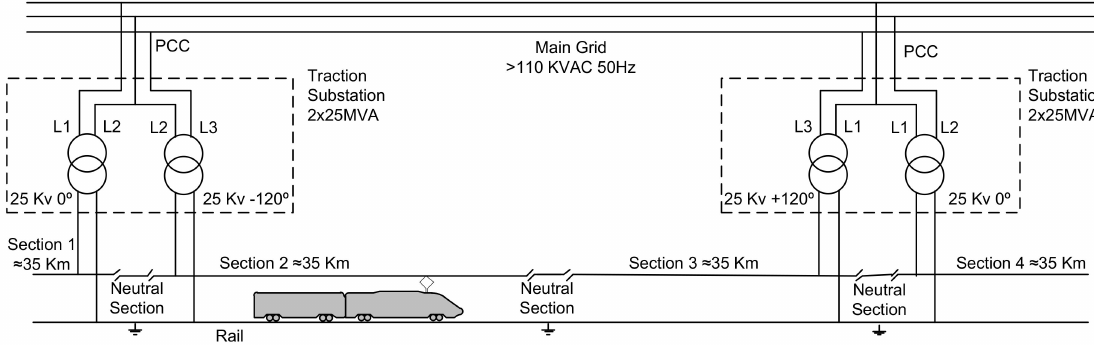
Figure 1. 1 × 25 KVAC 50 Hz high-speed railway electrical topology supply from the main